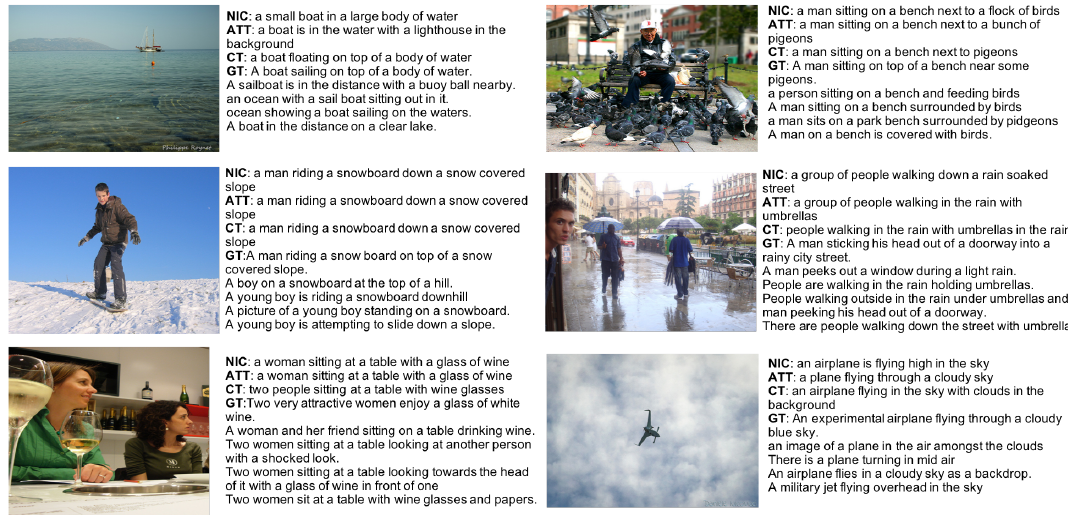
Figure 3. Examples of the generated sentences by our model. This figure contains six images which are randomly selected from the validation